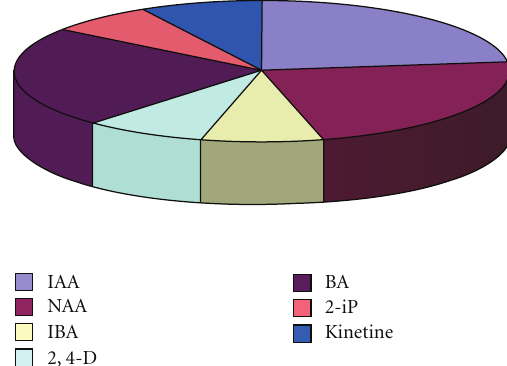
Figure 4: The relative shares of the most commonly used plant phytoregulators for Rhodiola callus induction in vitro